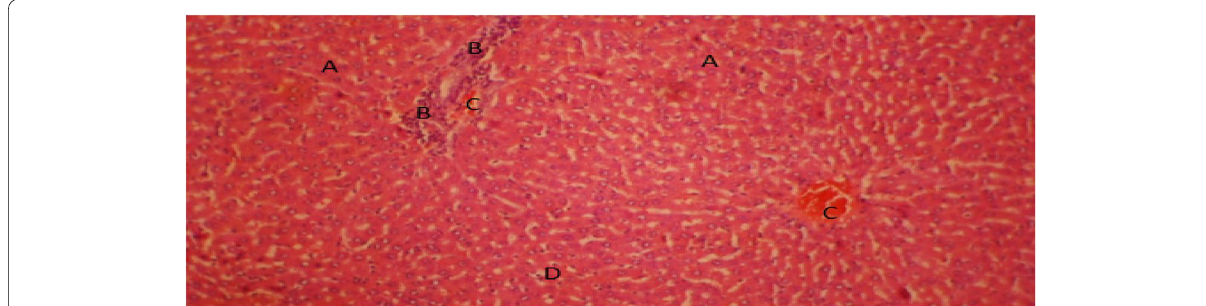
Fig. 7 Liver section of rat given SA for 14 days followed by 400mg/kg leaf extract for 14 days (Group 5) showing: A , normal hepatocytes, B , mild